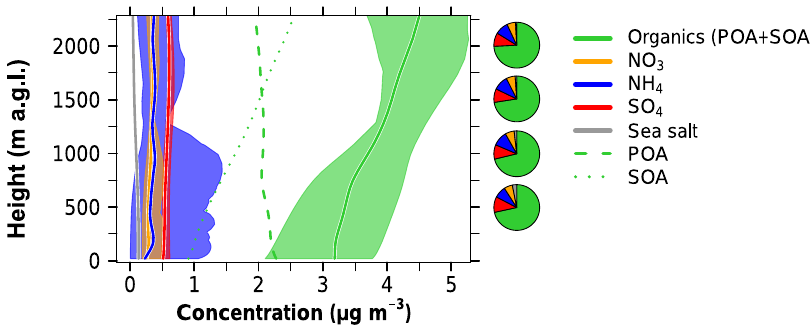
Figure C1. Vertical profiles (ma.g.l.) of aerosol concentrations (µgm − 3 ) for the median over the Ivory Coast (7.5–3 ◦ W, 4–10 ◦ N) with respect to the time period 2 July 15:00UTC and 3 July 15:00UTC. The colors refer to organics (POA + SOA; green solid line), NO 3 (orange solid line), NH 4 (blue solid line), SO 4 (red solid line) and sea salt (gray solid line). Additionally, POA and SOA are shown as dashed and dotted green lines, respectively. The shadings denote minima and maxima in the diurnal cycle mean profile and the pie charts on the right-hand side highlight the mean contribution of the single species to the total aerosol composition at 500, 1000, 1500 and